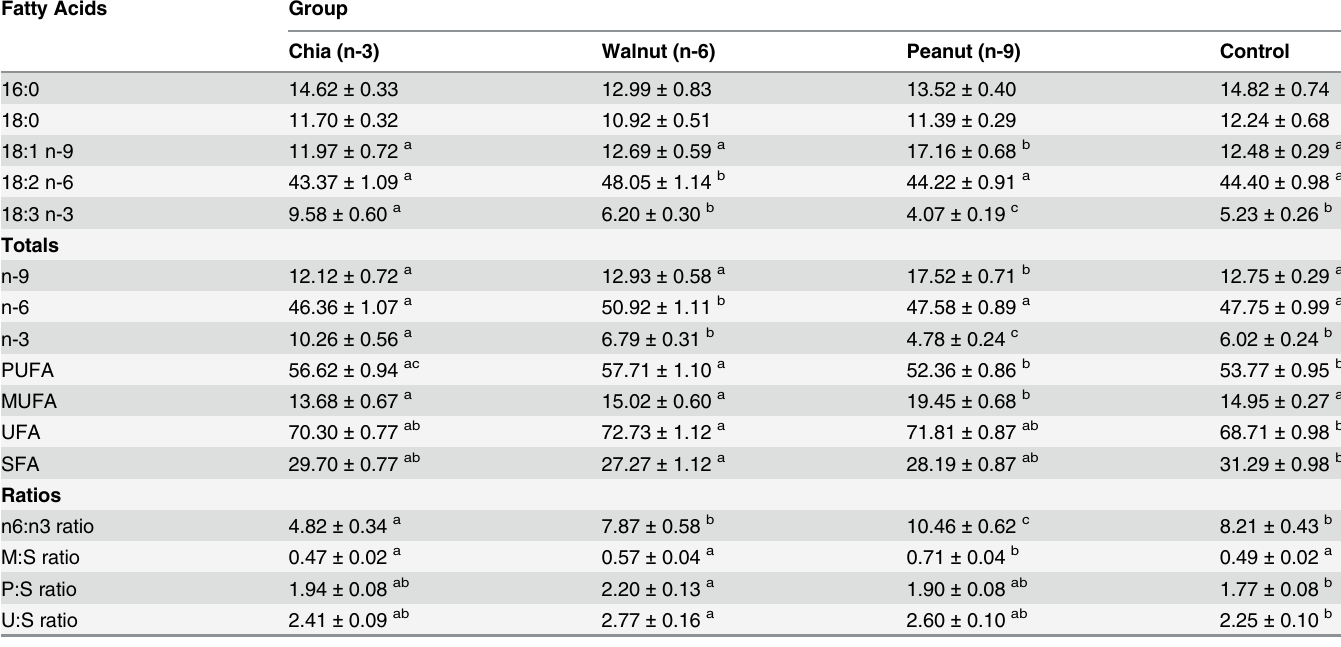
Table 1. Most prominent plasma fatty acids (% of total fatty acids) for the experimental